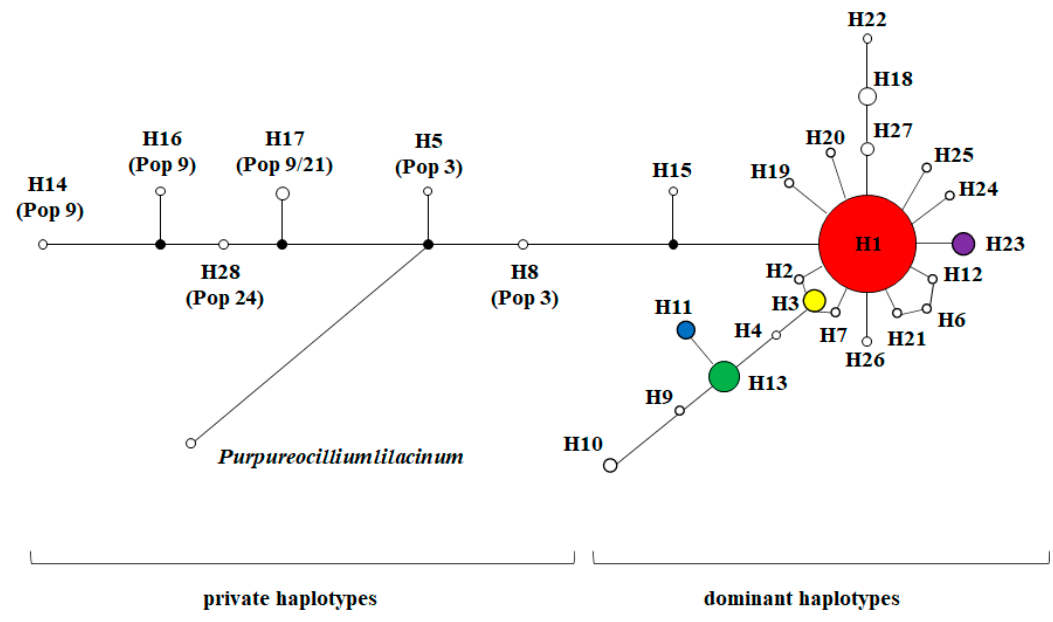
Figure 4. Phylogenetic network of NADPH-cytochrome P450 reductase-1 gene haplotypes of O. sinensis . Circle areas are proportional to haplotype frequencies. Circle colors are proportional to haplotypes defined in Figure 1. Purpureocillium lilacinum 36-1 (GenBank accession No. LCWV00000000.1) was used as an outgroup. Population codes correspond to those in Table S1.